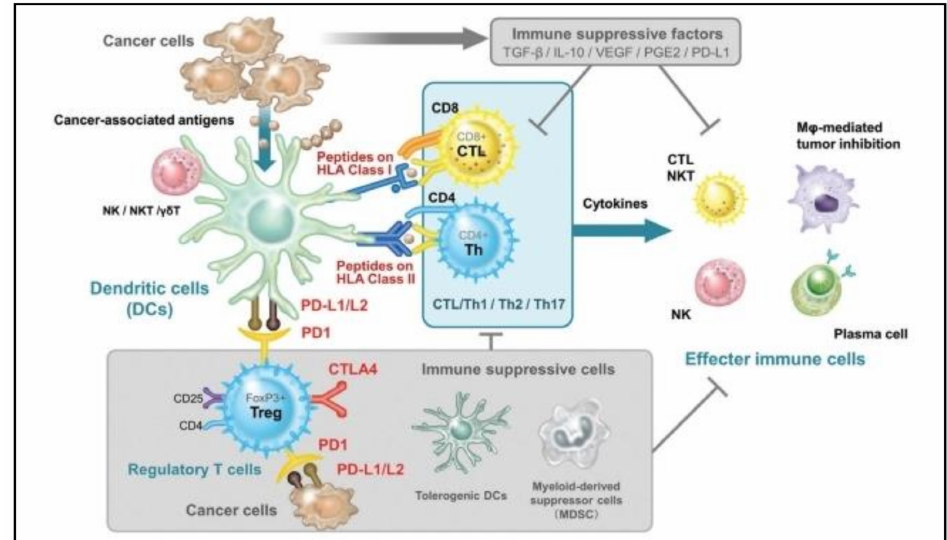
Figure 2. The dual immune stimulatory and immunosuppressive roles of DCs inside the TME. Reproduced with permission from [22]. Copyright 2016, Codon